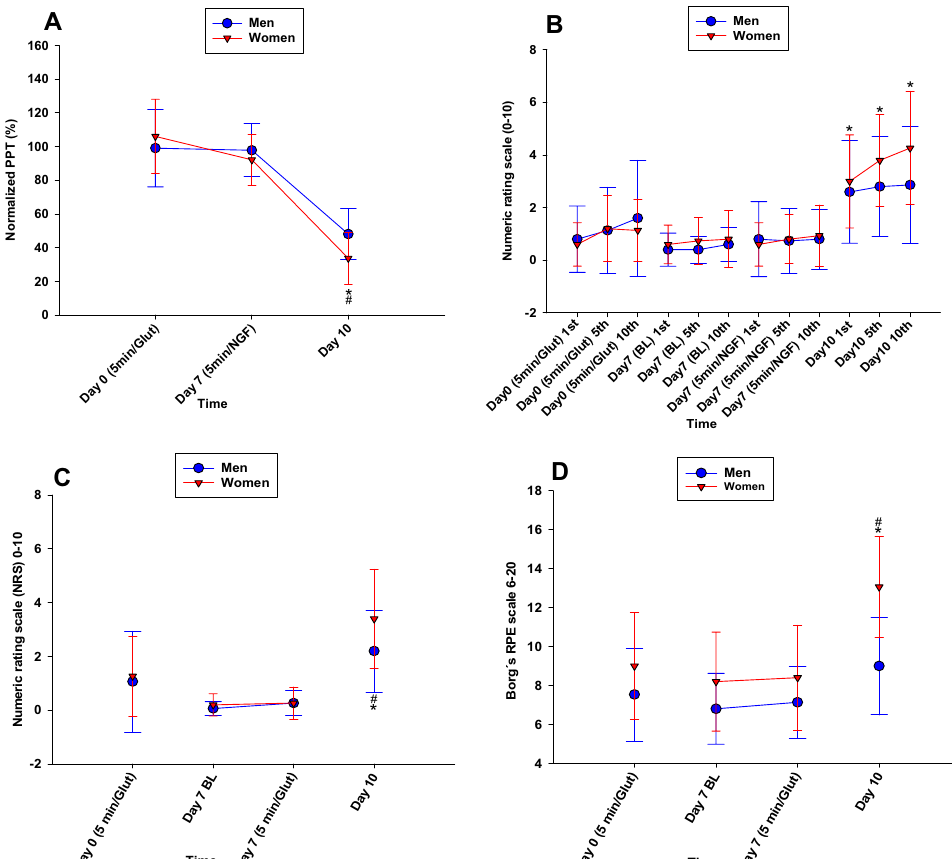
Figure 3. Graphs illustrating muscular sensitization by injection of glutamate and nerve growth factor. Measures of muscle sensitization assessed before (BL) and after injection of glutamate and nerve growth factor (NGF) into the masseter muscle of 15 healthy women and 15 age-matched men. ( A ) The percent change of pressure pain threshold (PPT) normalized to baseline. ( B ) Ratings of pain (NRS 0–10) for the 1st, 5th and 10th pressure stimuli applied during a temporal summation test. ( C ) Ratings of pain (NRS 0–10), and ( D ) fatigue (Borg’s RPE scale) evoked by a 1-min chewing test. All data are presented as mean (SD) for better visualization although ratings of pain and fatigue were analyzed statistically with non-parametric methods. *Significant different from other time points (P < 0.050). # Significant difference between sex (P < 0.050). BL baseline, 5 min/ Glut five min after glutamate injection, 5 min/NGF five min after NGF injection, NRS numerical rating scale, RPE rating of perceived